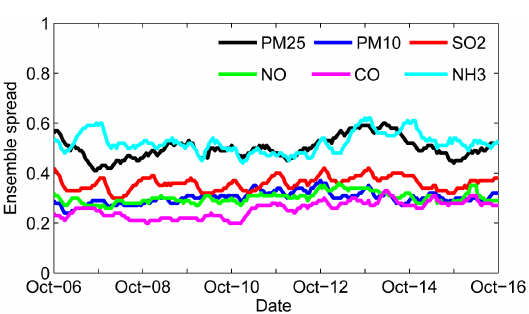
Figure 3. Time series of the area-averaged ensemble spread for the emission scaling factors over the Beijing–Tianjin–Hebei